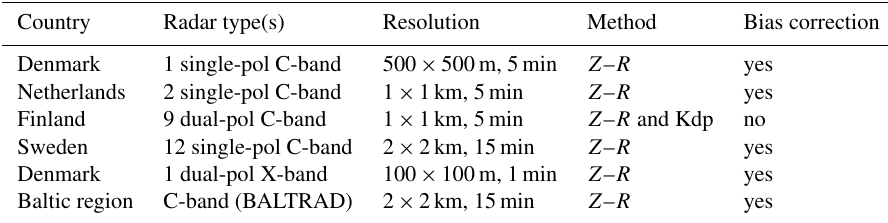
Figure 1. The four considered study areas in Denmark, the Netherlands, Finland and Sweden with the used rain gauges (black dots) and the location of the C-band radars marked by black crosses. The dashed lines denote circles of 100km radius around each radar. Due to maintenance and relocations, not all the radars were operating at the same time. Table 2. Radar products used in this